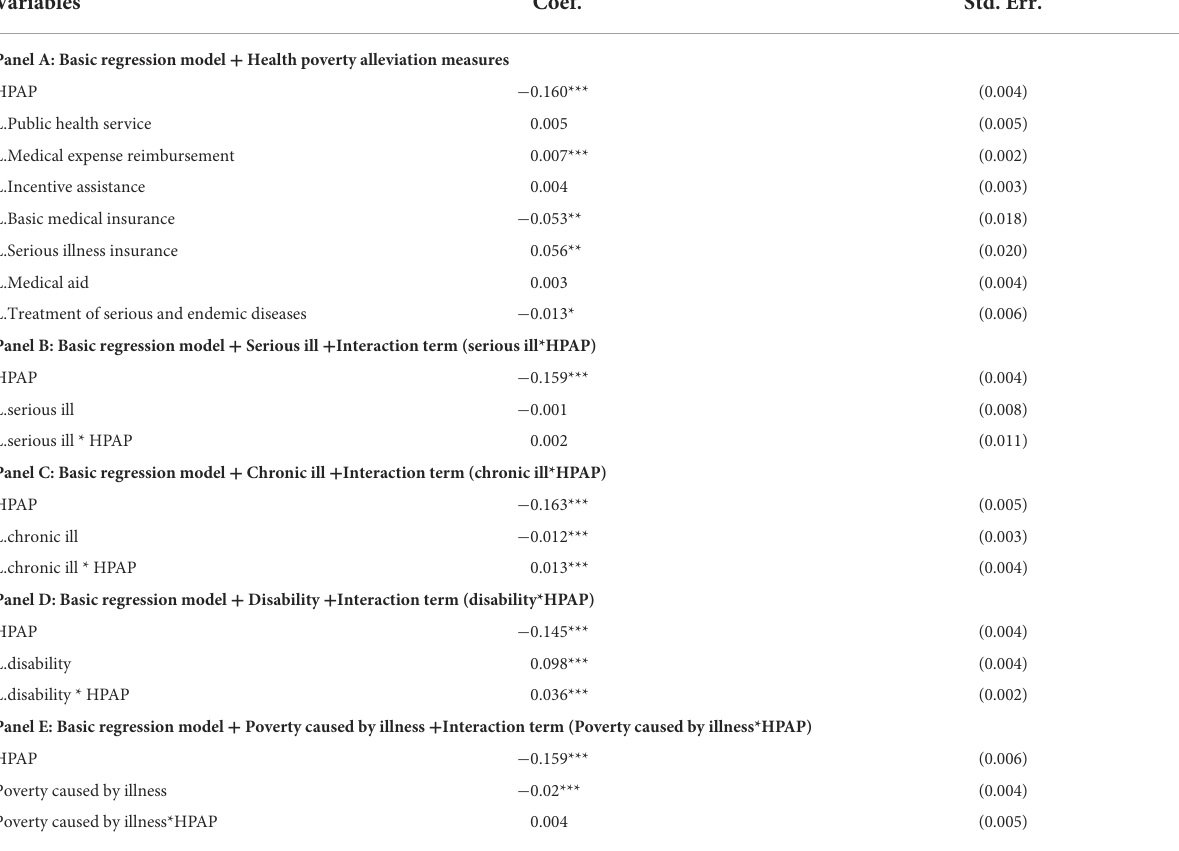
TABLE 6 Analysis of